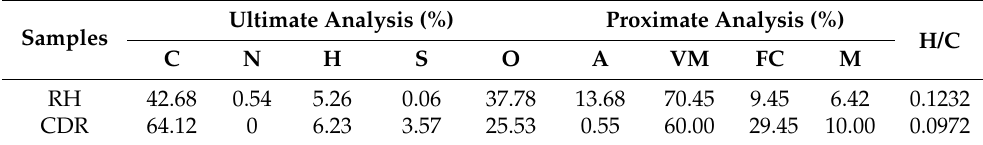
Table 1. Proximate analysis data for raw materials.